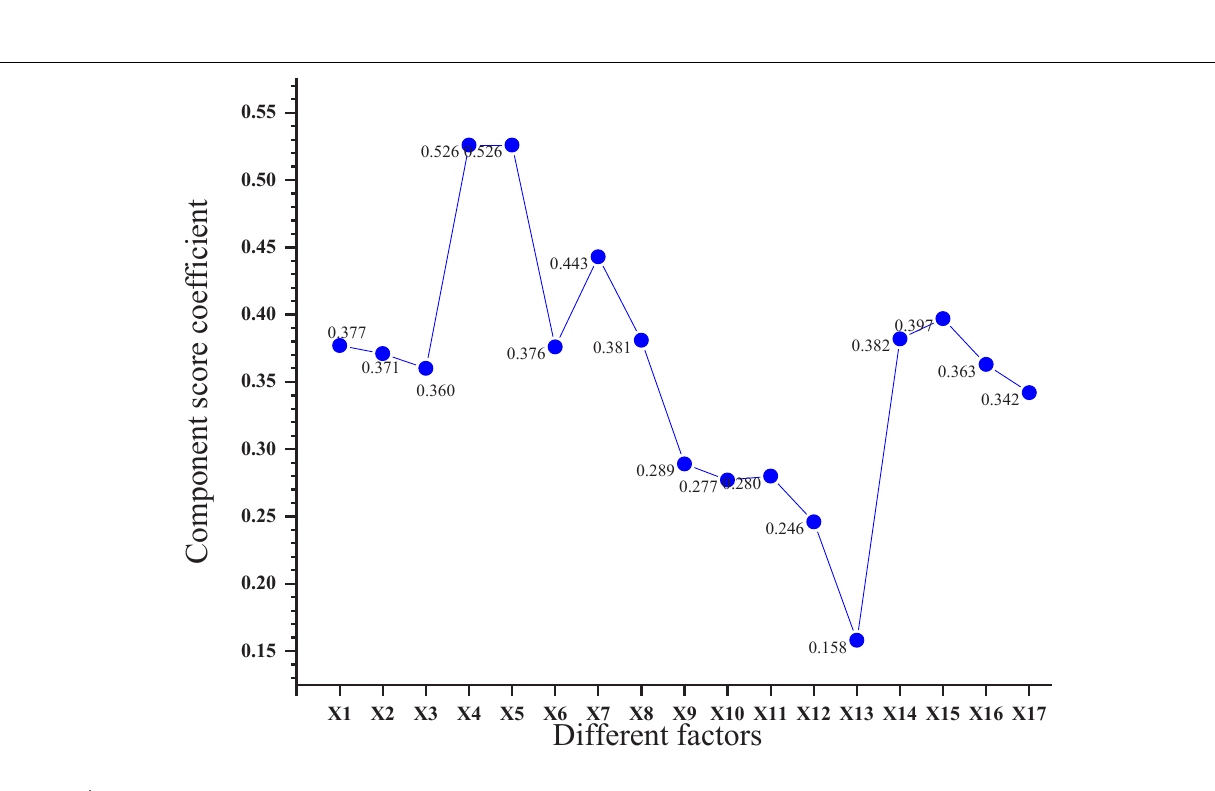
FIGURE 6 | Score coefficients of secondary index